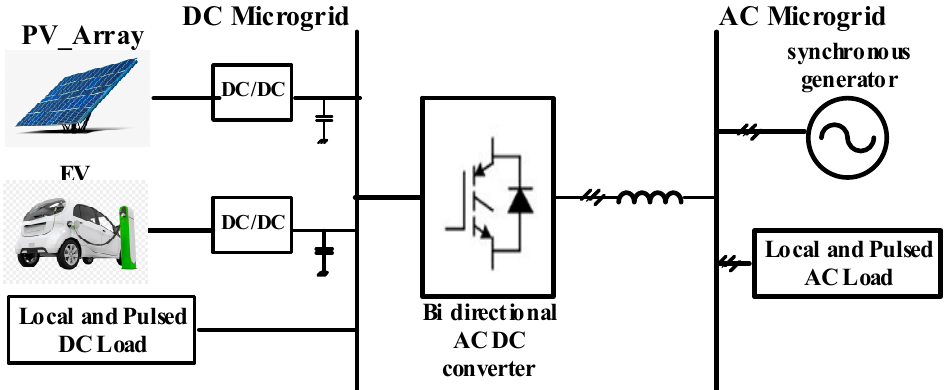
Figure. 1. Schematic configuration of the hybrid microgrid in this work. Figure 1. Schematic configuration of the hybrid microgrid in this